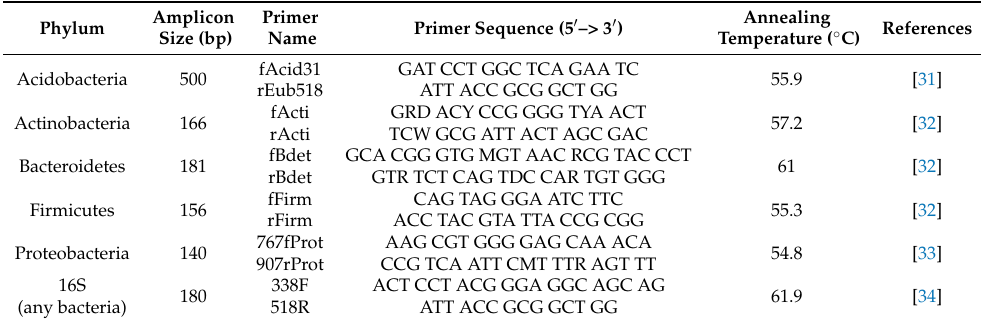
Table 4. Phyla primer pairs used in qPCR assay.